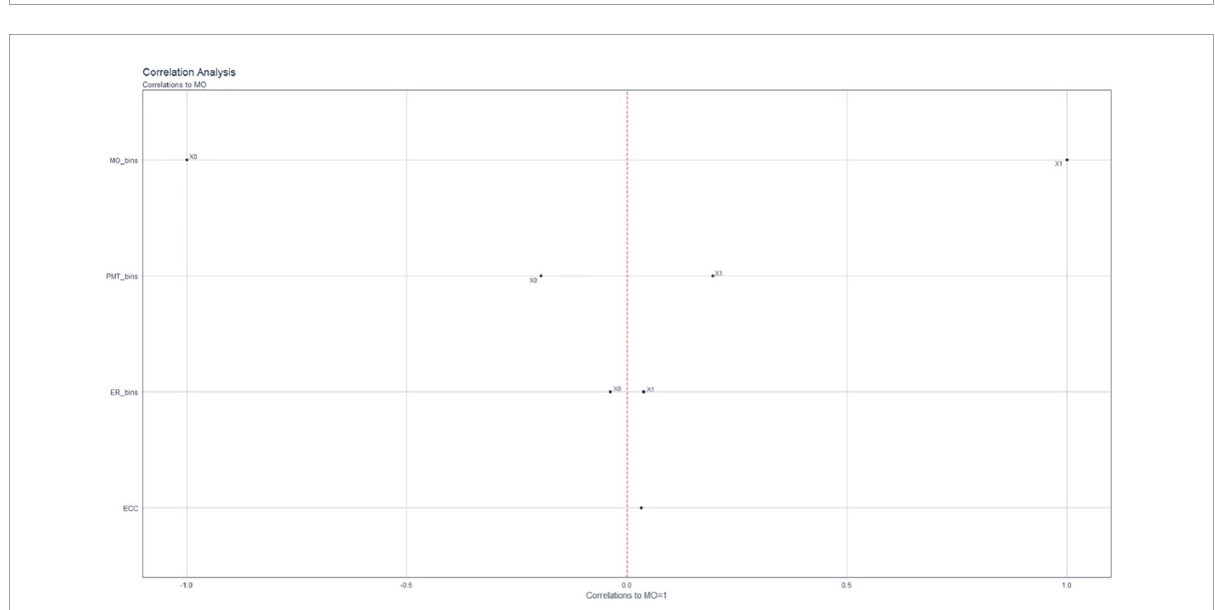
FIGURE3 Correlation Funnel. Scores of studying and teaching resources to the motivation